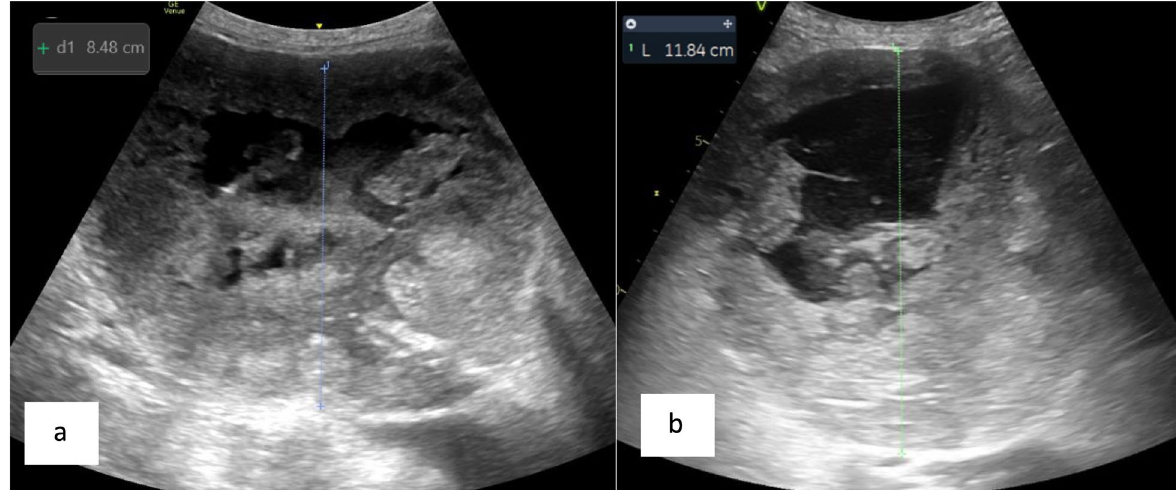
Fig. 2 a Diameter and appearances of the aneurysm sac directly following aspiration. This can be compared with b (follow up study), where re‑accumulation of the fluid component again results in dilatation of the aneurysmal